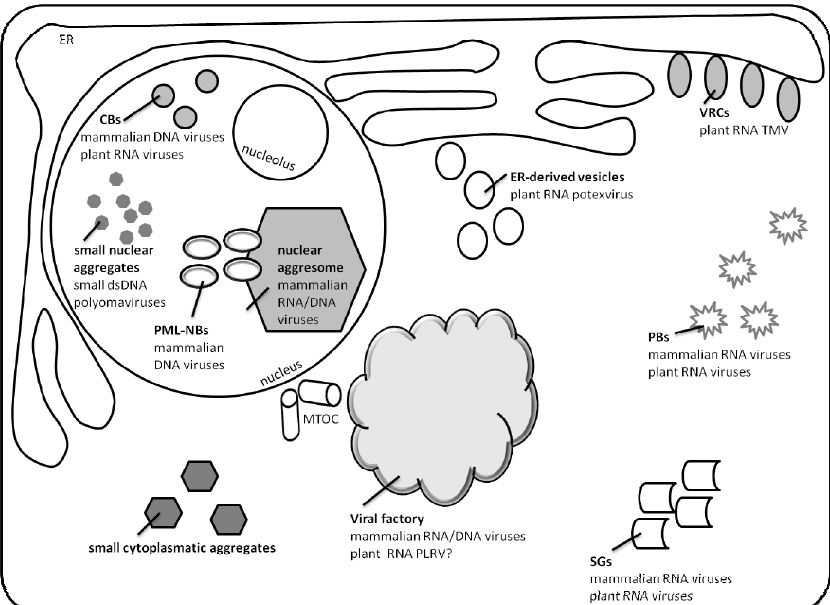
Figure 1. Cellular targets of viral infection induced aggregation. The scheme represents the different types of virus-induced aggregates discussed in the current review, as well as their cellular localization. Typical examples for each type are